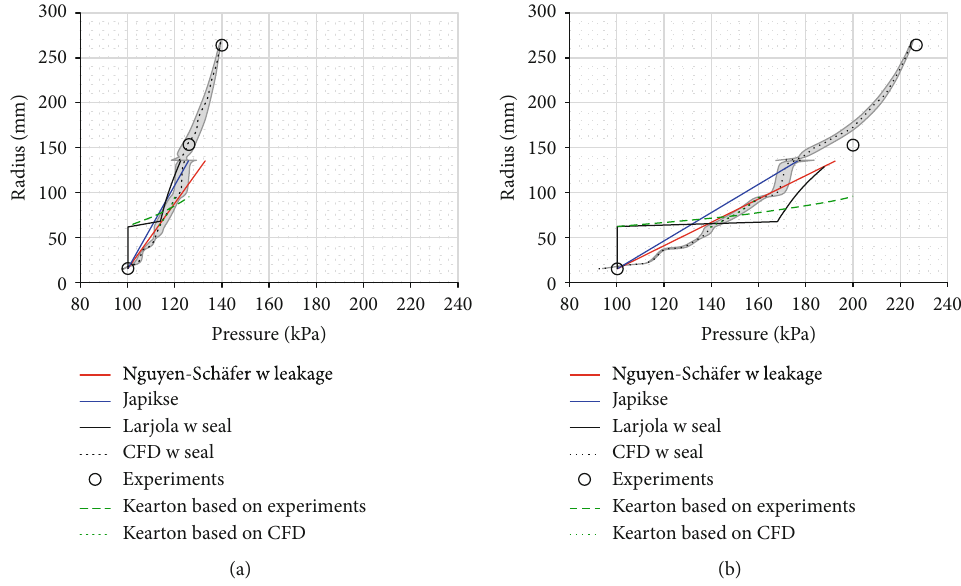
Figure 12: Pressure distribution on the back disk with labyrinth seal. Solid lines: three methods, dotted line: CFD, gray area: discretization error, circles: experiments, and green lines: theory of Kearton. (a) Point 1. (b) Point 9. Points 2 – 8 fall within these two